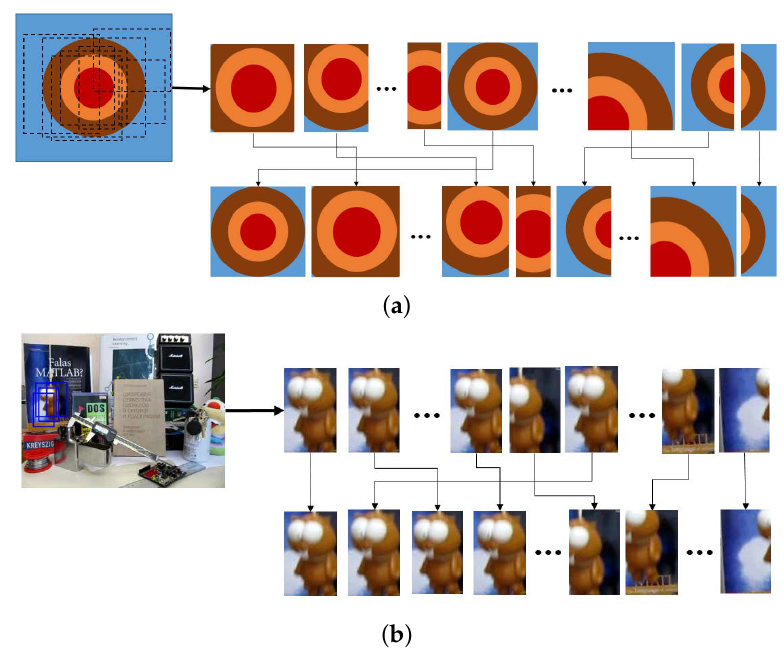
Figure 3. Procedure to find the most similar target object templates using confidence (Equation (9)). ( a ) Typical explanation to find the target object by weighting the scale factor from positive candidate templates to prevent drift, partial occlusion and scaling problems; ( b ) real image-based re-weighting procedure to find similar templates from positive image templates.